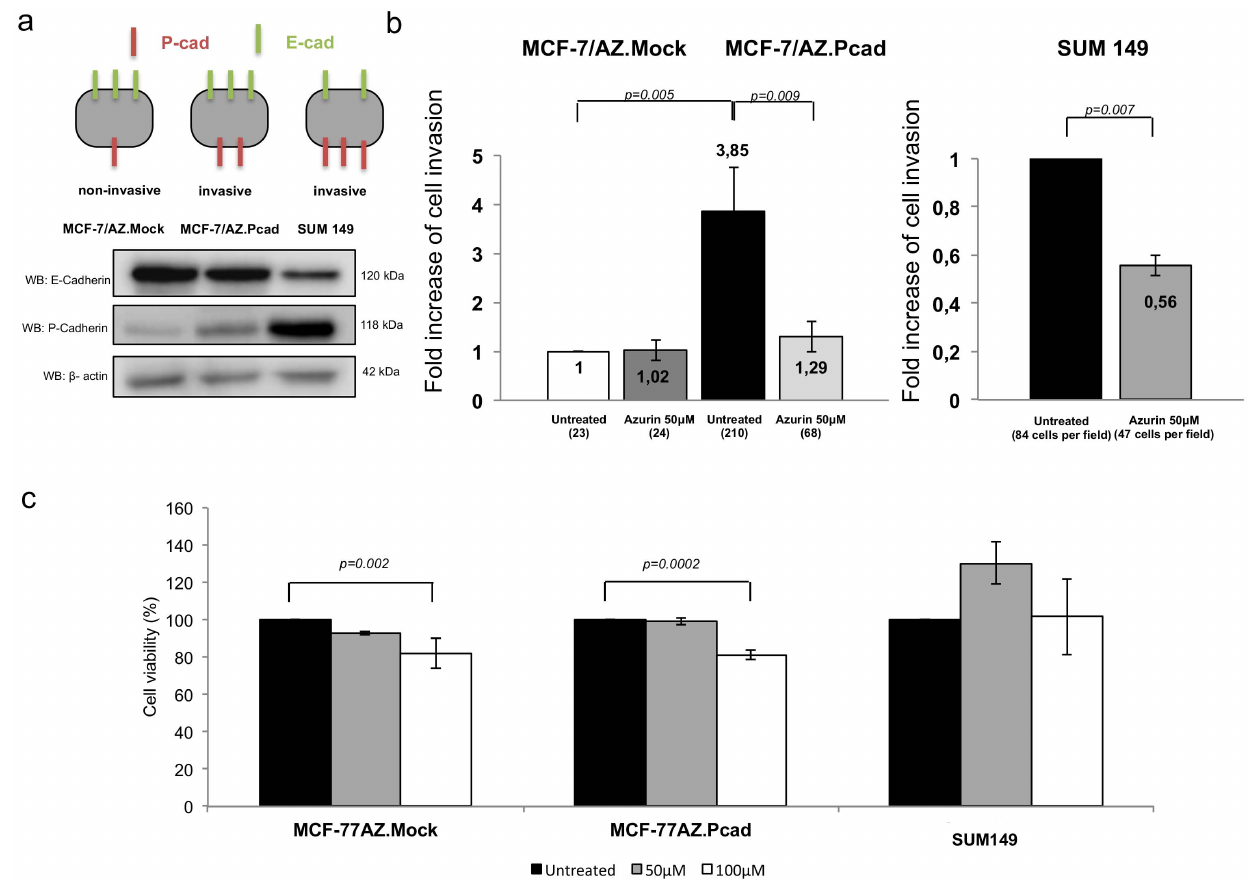
Figure 1. Azurin impairs invasion of breast cancer cells over-expressing P-cadherin. a) Schematic representation of the invasive profile of cell lines used in this work (upper panel) and E- and P-cadherin protein expression levels for each cell line (lower panel) b) Azurin decreases invasion of MCF-7/AZ.Pcad and SUM149 cells. Matrigel Invasion Assays showed that one single treatment of azurin at 50 m M for 48 h (MCF-7/AZ.Mock and MCF-7/AZ.Pcad) or 24 h (SUM149) significantly reduced the invasive behaviour of breast cancer cells.MCF-7/AZ.Mock cell line was used as a control and the invasion of this cell line was used to normalize the levels of invasion. c) Cell viability assessed with MTT assay of MCF-7/AZ.Mock, MCF-7/ AZ.Pcad and SUM149 cell lines in the presence of azurin. Cells were plated in 96-well plates in the presence of 50 and 100 m M of azurin for 24 h (SUM149) or 48 h (MCF-7/AZ.Mock and MCF-7/AZ.Pcad) to match the time course of invasion assays for each cell line. Control cells received complete media without